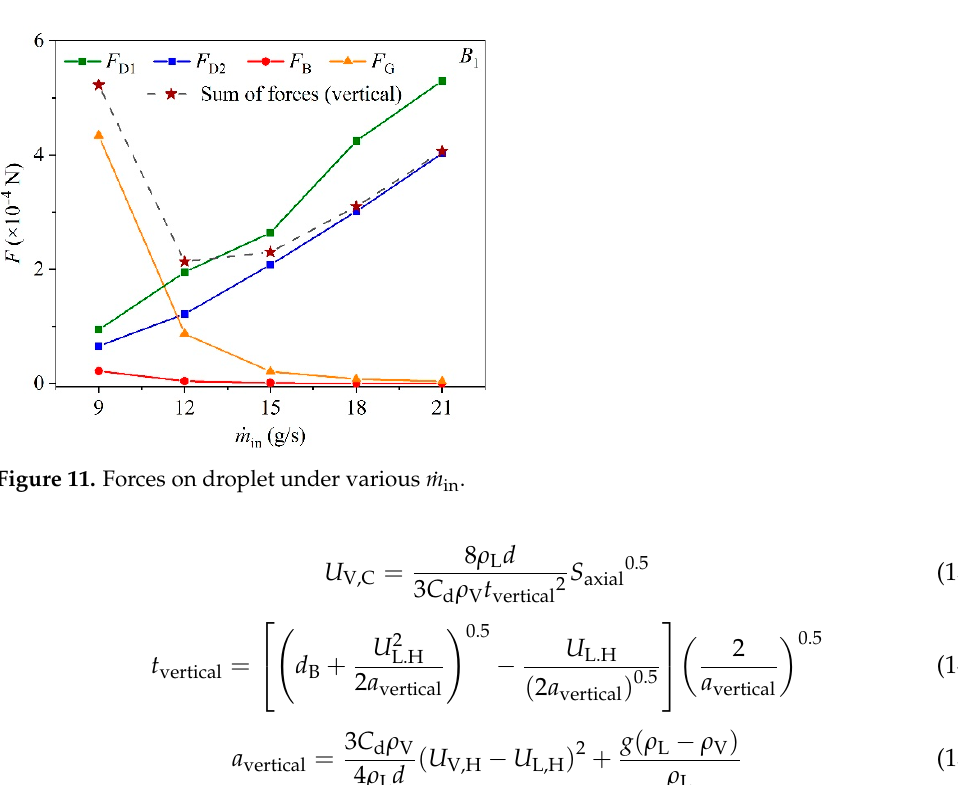
Figure 10. Forces on droplet in the header.